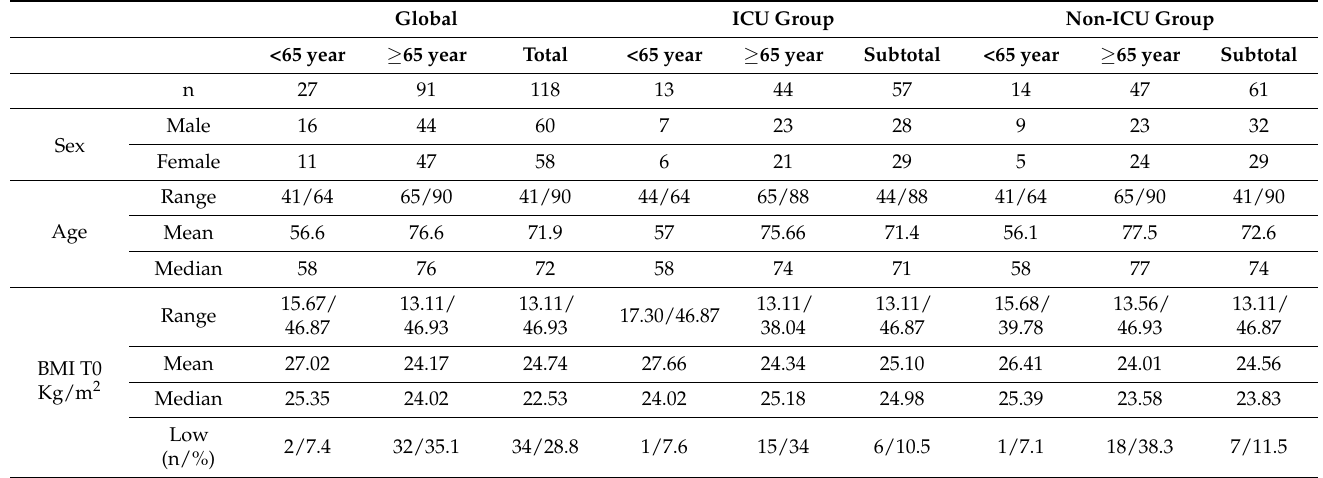
Table 1. Characterization of subjects and respective results from Body Mass Index (BMI) in all evaluation moments (T0; T1;